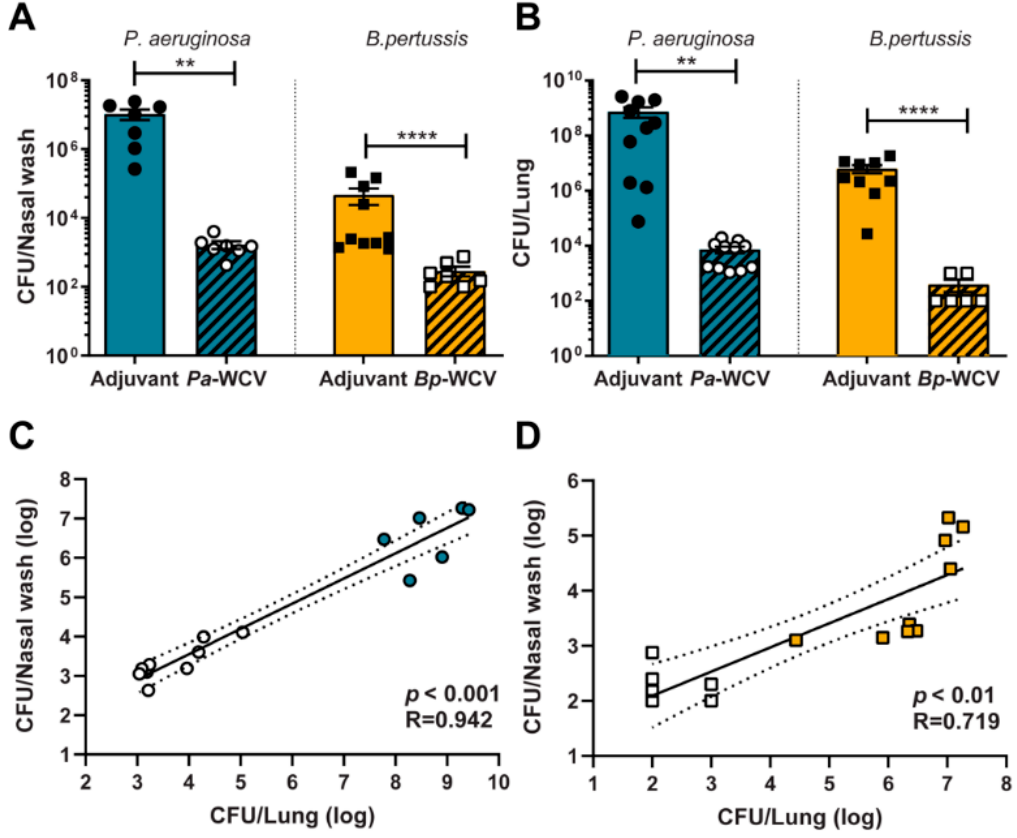
Figure 1. Intranasal administration of whole cell vaccination against P. aeruginosa or B. pertussis reduces bacterial burden in lung and nasal wash following challenge with each pathogen, respectively. Sixteen hours post-challenge, nasal wash ( A ) and lung ( B ) bacterial burden in euthanized mice groups. Each dot represents an individual mouse. Circles indicate infection with P. aeruginosa , squares indicate infection with B. pertussis , black-filled indicates adjuvant-vaccinate, white-filled points indicate whole cell immunized. The error bars represent the standard error of the mean ( n = 6–10 per group). The asterisks and brackets refer to statistical significance determined by ANOVA with Multiple Comparisons: ** p ≤ 0.01; **** p ≤ 0.001. ( C ) and ( D ) Correlation of number of bacteria in nasal wash to number of bacteria in lung, per each type of infection. Color filled points indicate adjuvant vaccinated animals and white filled points indicate animals that had received whole cell vaccination. The R 2 and p values were calculated using linear regression analysis.